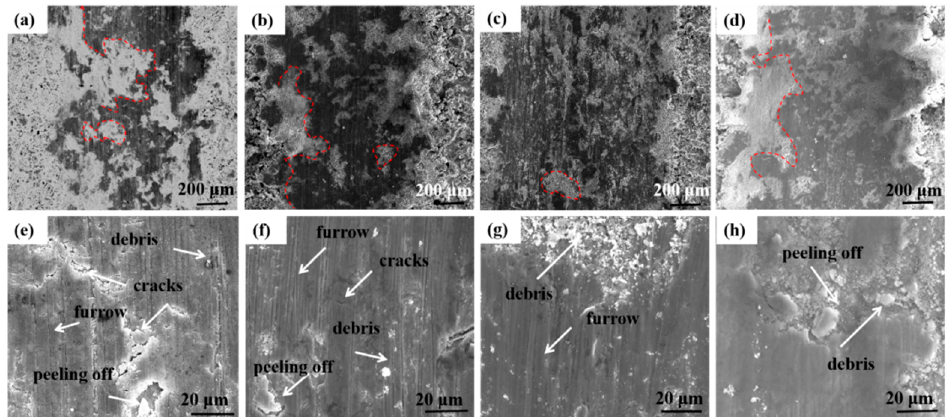
Figure 9. Wear scars of FeCoNiCrMo 0.2 high entropy alloy coating sprayed by plasma at different currents under 25 N load ( a , e ) 250 A, ( b , f ) 350 A, ( c , g ) 450 A, ( d , h ) 550 A. (red dot line area is typical wear scar)